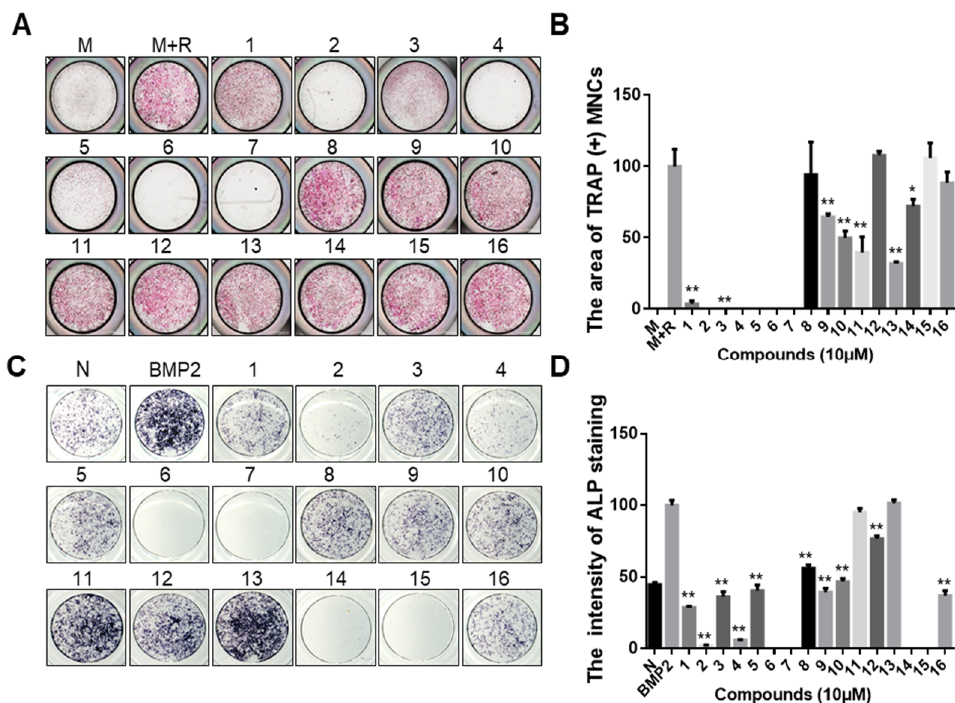
Figure 1. Effect of epigenetic regulator inhibitors on osteoclast differentiation and osteoblast differentiation. ( A ) BMMs were treated with M-CSF (30 ng/mL) and RANKL (50 ng/mL), and then incubated with or without epigenetic regulators (10 µ M). After 4 days, the cell was fixed and stained for the TRAP assay. ( B ) Quantitative analysis of the area of TRAP-positive multinucleated osteoclasts [TRAP (+) MNCs] by Image J software. M: M-CSF, M+R: M-CSF + RANKL. * p < 0.05, ** p < 0.01 versus the control (M+R) group. ( C ) Primary calvarial pre-osteoblast cells were treated with BMP2 (100 ng/mL) and co-cultured with or without epigenetic regulators (10 µ M) for 7 days. The differentiation cell was stained with ALP. ( D ) Quantified analysis of ALP staining intensity by Image J software. “N” indicates no BMP2-treated group. ** p < 0.01 versus the BMP2 treatment group. The structures of the compounds corresponding to these numbers are shown in Table S1.